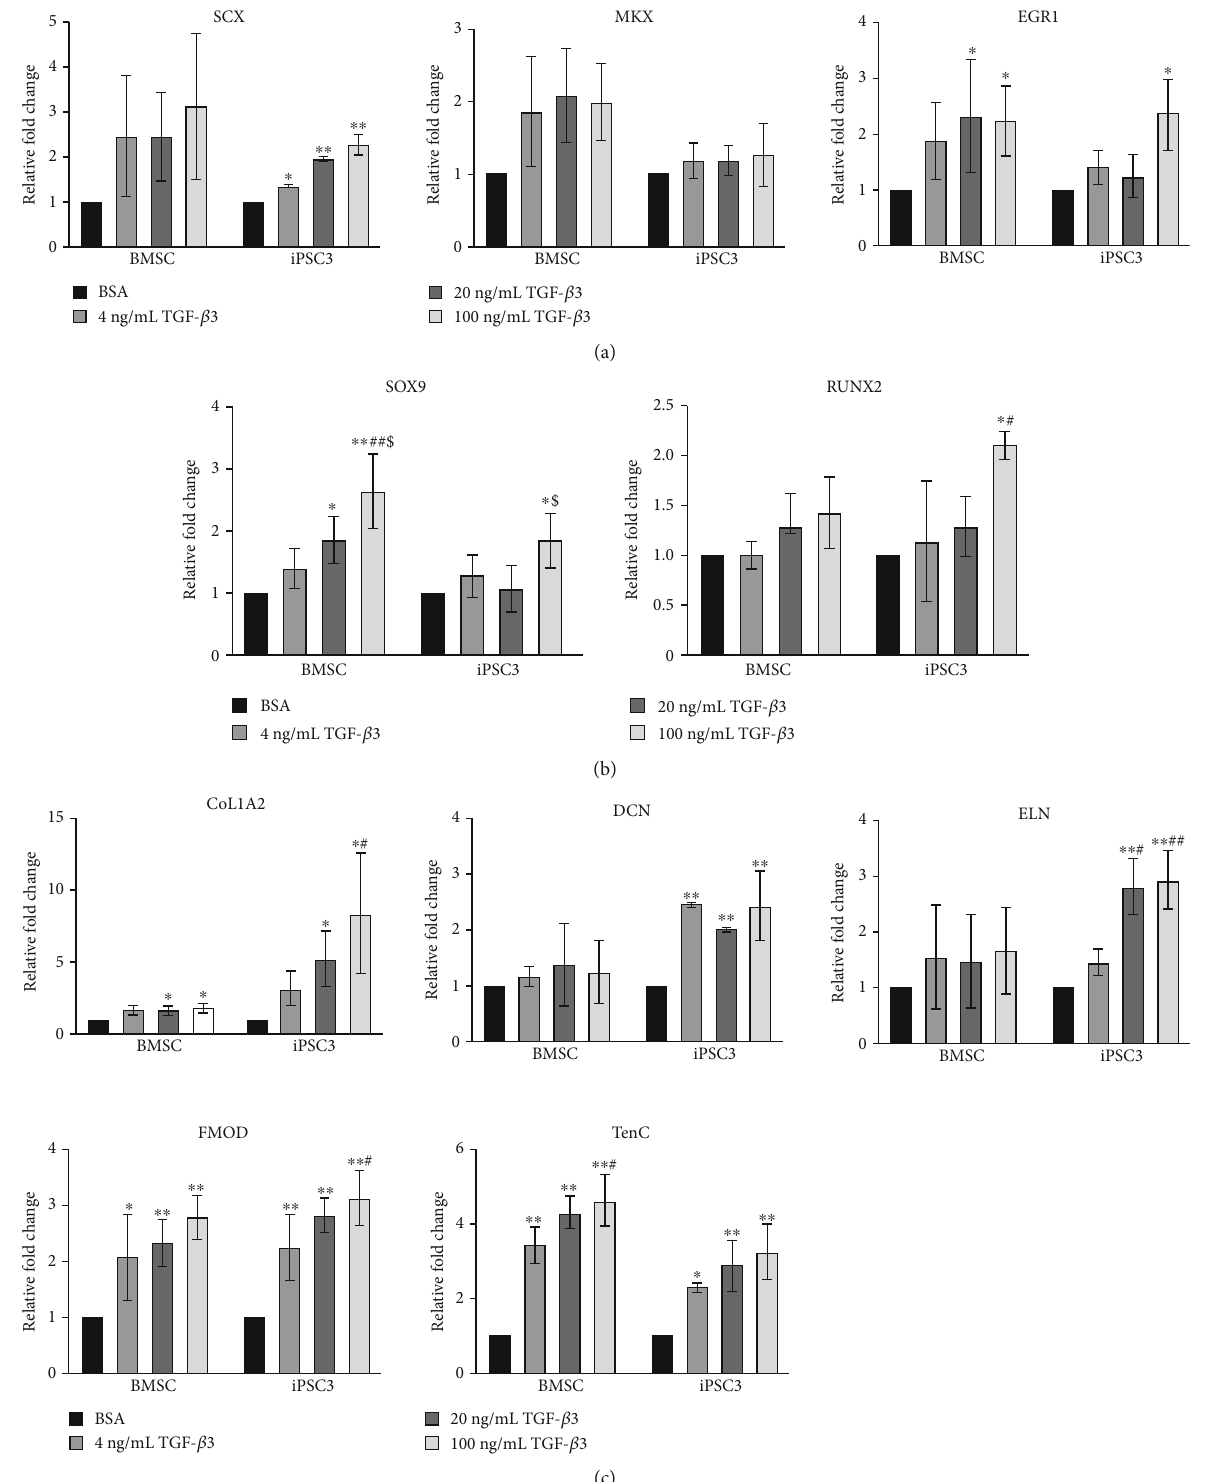
Figure 1: Dose e ff ects of TGF- β 3 on tenogenic gene expression in BMSCs and teno-iPSCs. Cells were treated with vehicle medium (0) or various concentrations of TGF- β 3 (4, 20, and 100ng/mL) for 5 days, and cDNA was synthesized from total RNA. Expression of tenogenic transcription factors (a), chondrogenic transcription factor SOX9, osteogenic transcription factor RUNX2 (b) and tenocyte-related ECM genes (c) was determined by qPCR. Relative fold change for each group was calculated by comparison to vehicle medium group, and data for BMSCs were summarized from 3 horses, and data for teno-iPSCs were summarized from 3 passages. ∗ Data were compared to BSA control; # data were compared to the 4ng/mL group; $ data were compared to the 20 ng/mL